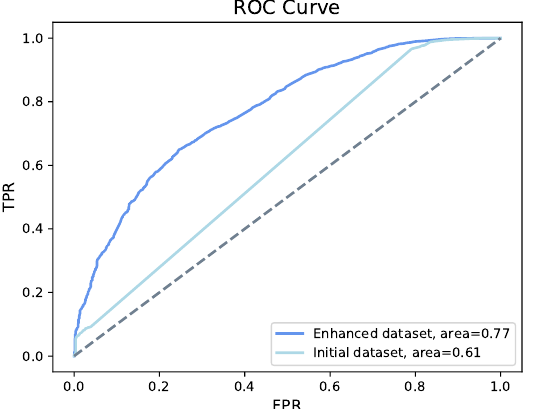
Figure 5. ROC of XGBoost. XGBoost shows an the accuracy of 94% on the initial structured dataset and an accuracy 97% on the enhanced structured dataset, with an increase of the area under the curve from 61% to 77%.